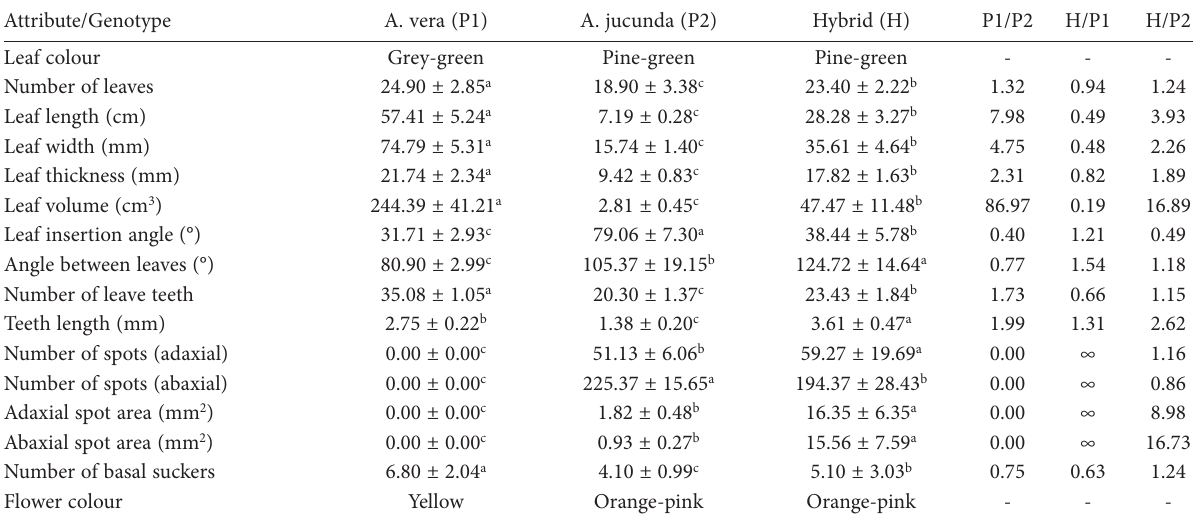
Table 1. Morphological attributes evaluated in adult plants of the progeny and their parents Aloe jucunda and A. vera , under nursery condi- tions in Cumaná (Venezuela).